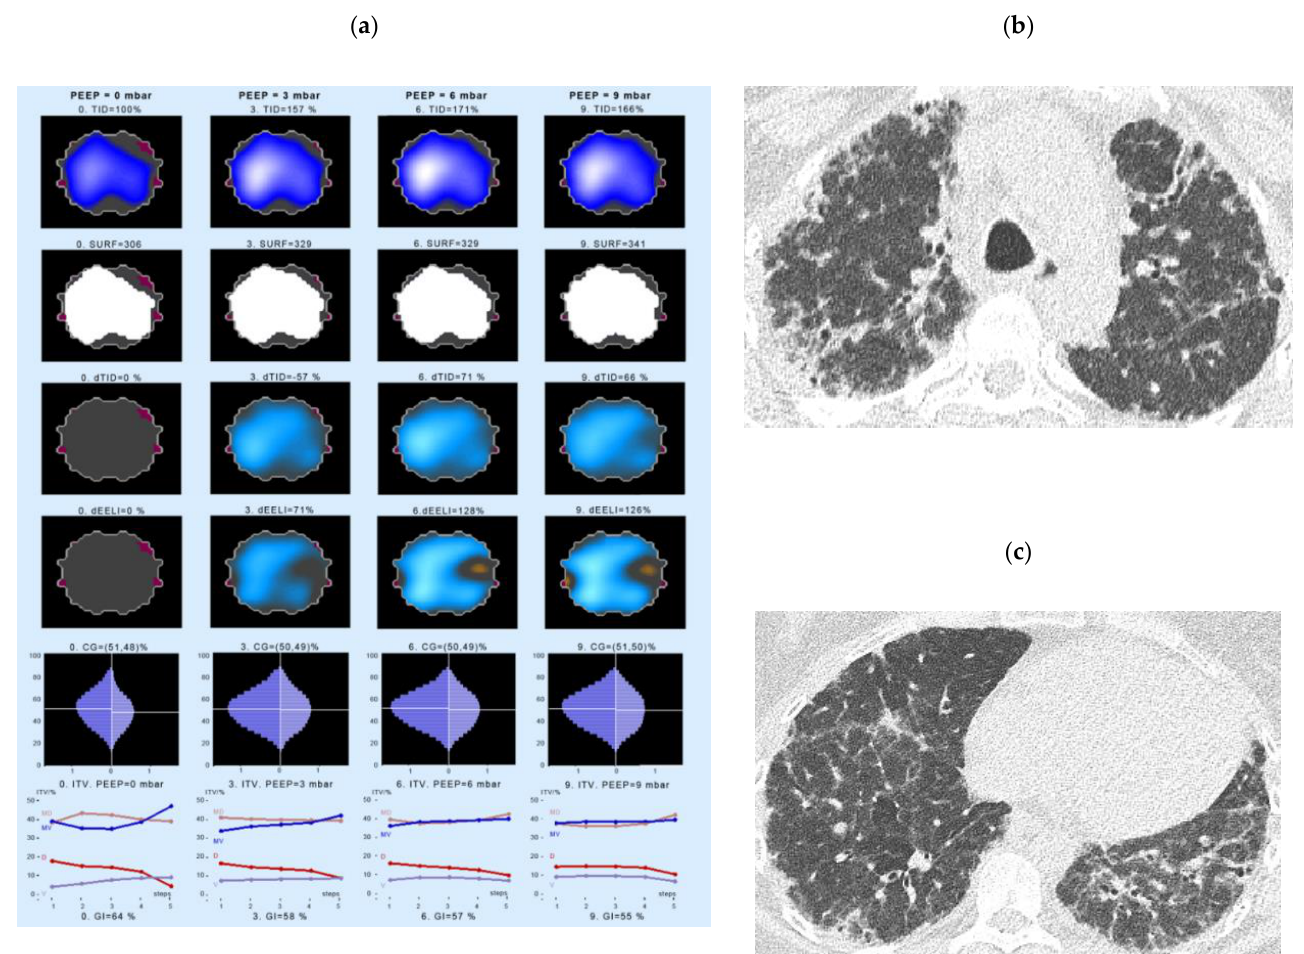
Figure 5. Changes in regional lung ventilation under increasing PEEP in IPF patient #8. Left panel ( a ): Spatial distribution of TID, SURF, dTID, dEELI in the EI tomogram at a PEEP of 0 (left), 3 (2nd left), 6 (3rd from left) and 9 levels (right column). The lowest panel indicates the intratidal gas distribution (ITV) for four anatomical areas during one respiration. Given are the distribution of ventilation into the ventral (V), dorsal (D), medio-ventral (MV) and medio-dorsal (MD) regions of the lung. The X scale (1–5) shows the entire inspiration, divided into 5 steps. Right panel ( b , c ): The respective high resolution CT picture corresponding to the ROI of EIT measurement is shown. Abbreviations: CG—center of gravity of ventilation distribution; dEELI—difference of end-expiratory lung impedance over time; ITV—intratidal gas distribution; PEEP— positive end-expiratory pressure; SURF—surface of ventilated areas; TID—tidal impedance distribution; dTID—difference of TID over time.